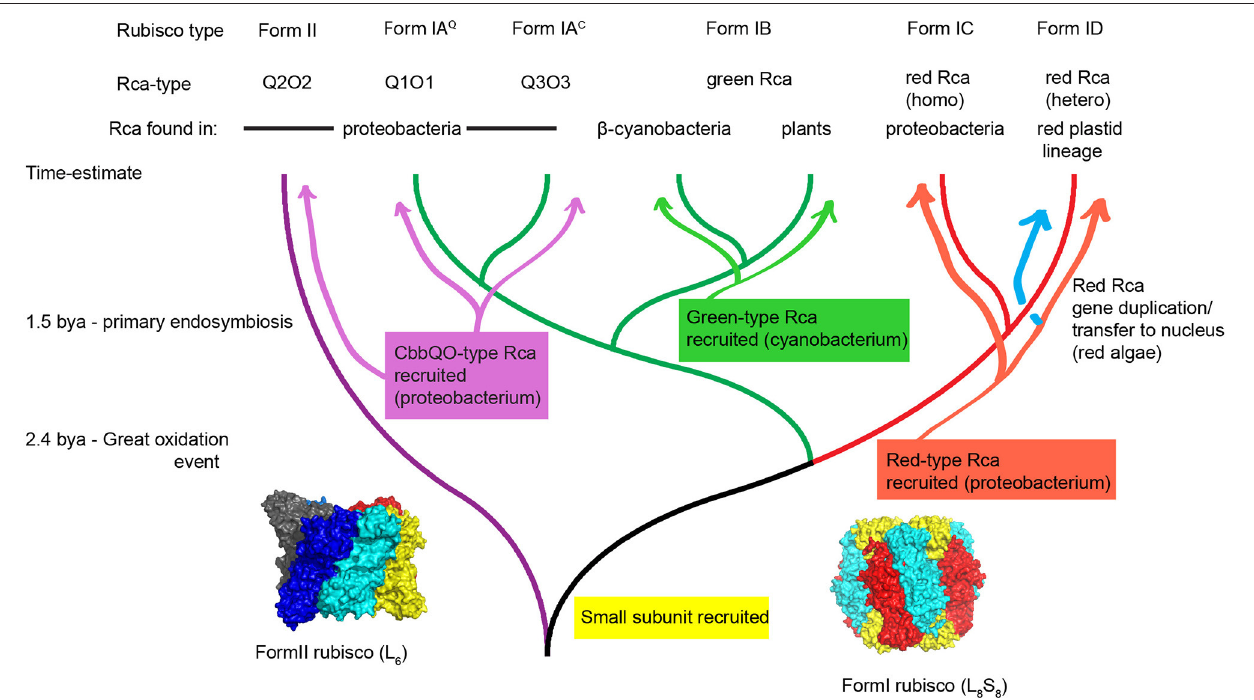
FIGURE 2 | Hypothetical scheme for the evolution of Rubisco and its activases. Following the great oxidation event at least three different classes of Rubisco activase were recruited from the general molecular chaperone machinery toward a specialized Rubisco activase function in diverse autotrophic organisms. Green type and red-type Rca was maintained in eukaryotic phototrophs of the green and the red plastid lineage respectively. A phylogenetic tree was drawn using Rubisco large subunit sequences that are associated with activases. It is important to note that regarding non-red prokaryotic Rubisco sequences, many instances exist that do not have identifiable activase genes encoded in the same genome. Surface representations of a hexameric Form II Rubisco (pdb:4lf1) and spinach Form I Rubisco (pdb:8ruc) are shown. Structures shown in this paper were drawn using